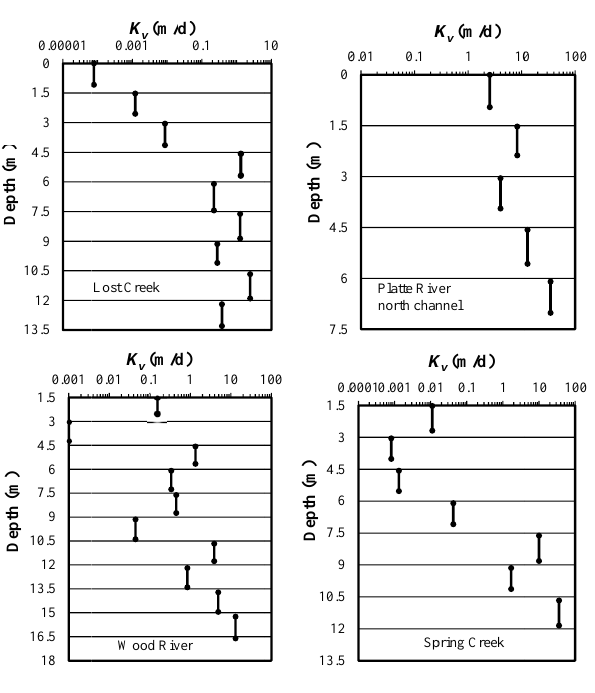
Fig. 3. Distribution of K v with depth in losing streams for four study sites in the Platte River north channel, Wood River, Spring Creek, and Lost Creek of south-central